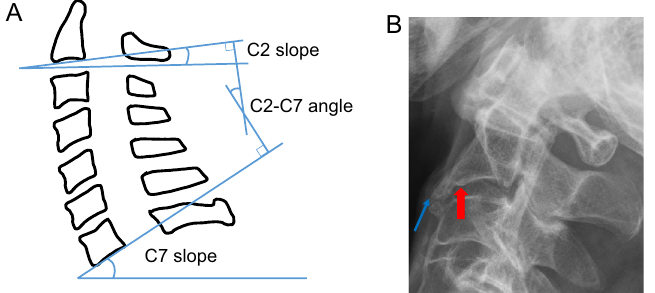
Figure 2. ( A ) The C2 slope is the angle between the C2 lower endplate and the horizontal line, and the C7 slope is the angle between the C7 lower endplate and the horizontal line. The C2-C7 angle is the angle between C2slope and C7slope. ( B ) The red arrow indicates the original vertebral corner. The blue arrow indicates the tip of the osteophyte. The point is marked at the red